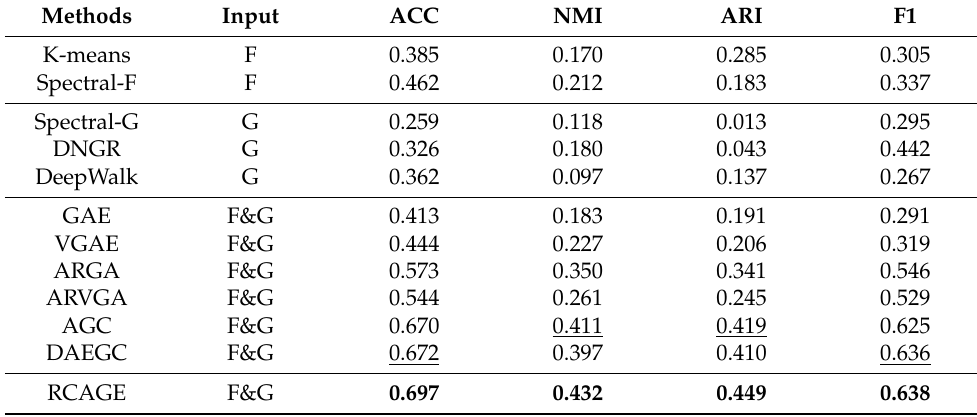
Table 3. Node-clustering performance on Citeseer.